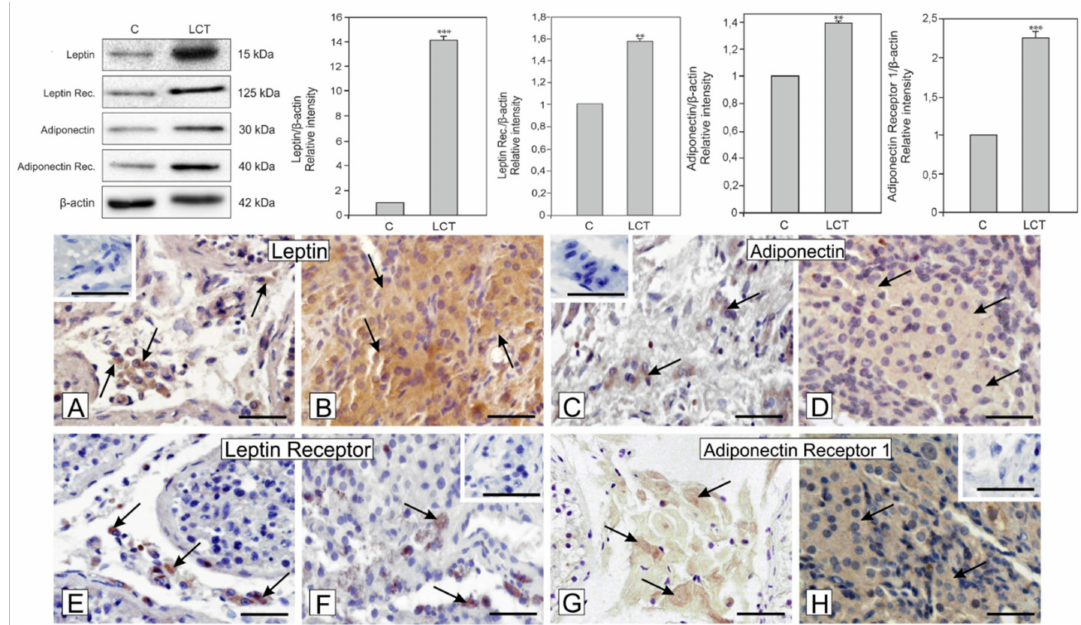
Figure 2. Expression ( upper panel : blots and graphs) and localization of leptin and adiponectin and their receptors ( lower panel : microphotographs) in a Leydig cell tumor. Representative blots and relative expression (arbitrary units) of qualitative expression of leptin, adiponectin, and their receptor proteins in Leydig cell of control (C) testis and Leydig cell tumor (LCT). The relative amount of respective proteins normalized to β -actin. Relative intensity of bands from three separate analyses is expressed as means. Asterisks show significant di ff erences between expression of control and treated Leydig cells. Data is expressed as means ± S.D. Values are denoted as ** p < 0.01 and *** p < 0.001. Representative microphotographs of immunohistochemical localization of leptin ( A , B ), adiponectin ( C , D ), and their receptor proteins ( E , F and G , H ; respectively) in Leydig cell of control (C) testis and Leydig cell tumor (LCT). Counterstaining with hematoxylin. Bar 20 µ m. Inserts at ( A , C , F , H )—negative controls. Immunostaining was performed at least three times. Arrows- depict positive